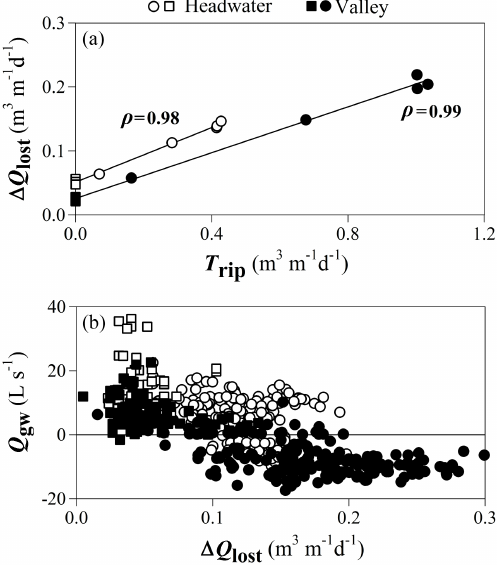
Figure 3. Relationship between (a) the monthly mean of daily ri- parian transpiration estimated from sap-flow data ( T rip ) and riparian evapotranspiration estimated as the difference in diel discharge vari- ation between the top and the bottom of each stream reach ( (cid:49)Q lost ), and (b) (cid:49)Q lost and daily net riparian groundwater inputs ( Q gw ) for the headwater (white) and valley (black) reaches. Data are shown separately for the vegetative (circles) and dormant (squares) pe- riod. The Spearman coefficients are indicated in (a) (in both cases: p < 0.01, n = 8). In (b) , the Q gw = 0 line is shown as a reference of nil net riparian to stream-water inputs; Q gw > 0 and < 0 indi- cates when the stream reach was net gaining and net losing water,